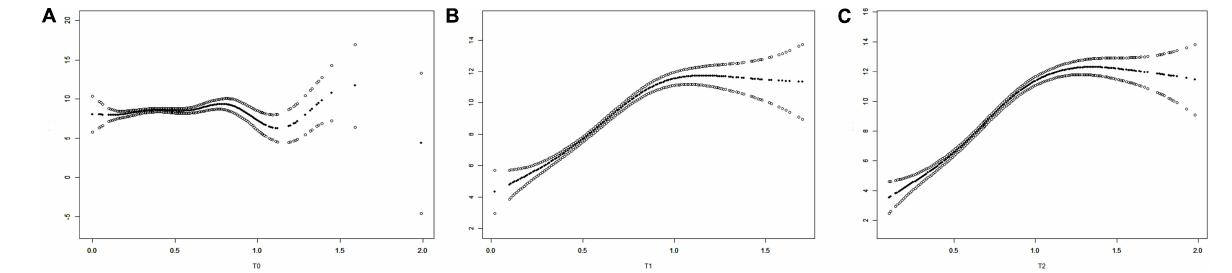
(MII) oocytes, numbers of TQEs, numbers of blastocyst-stage embryos, TQE formation rate, and blastocyst formation rate, are shown in Supplementary Figures 1–5 . The fitting curves